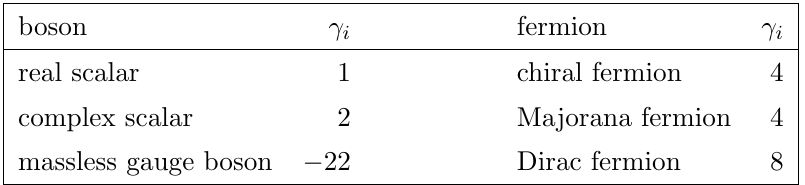
Table 1 . RGE contributions of di(cid:11)erent particle types, where the minus sign is indicative for the asymptotic freedom in non-Abelian gauge